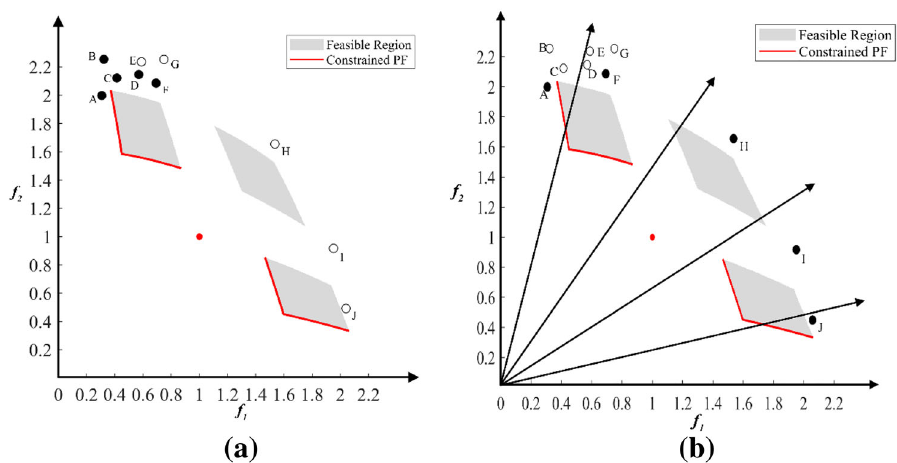
Fig. 3 Hypothetical distributions of ten candidate solutions A–J on MW11, the black dots in a and b are the best five solutions selected by CDP and EGDCMO,